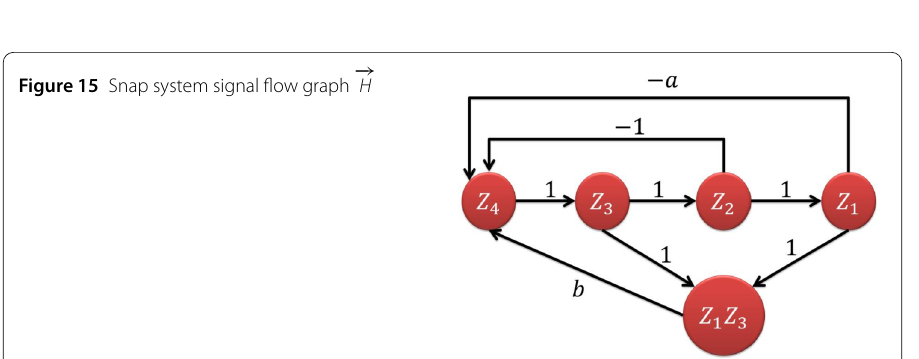
Figure 14 Illustrative example in secure communication